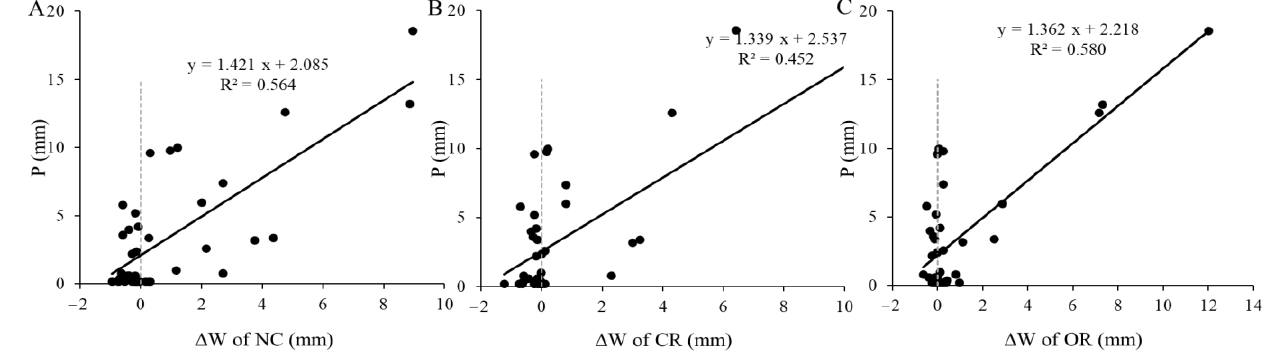
Figure 5. Relationships between ∆ W and precipitation on rainy days in the NC treatment ( A ), CR treatment ( B ) and OR treatment ( C ). The dashed line is the zero-value dividing line. P: precipitation, ∆ W : the change in soil water storage, NC: natural condition, CR: canopy + roots, OR: only roots.